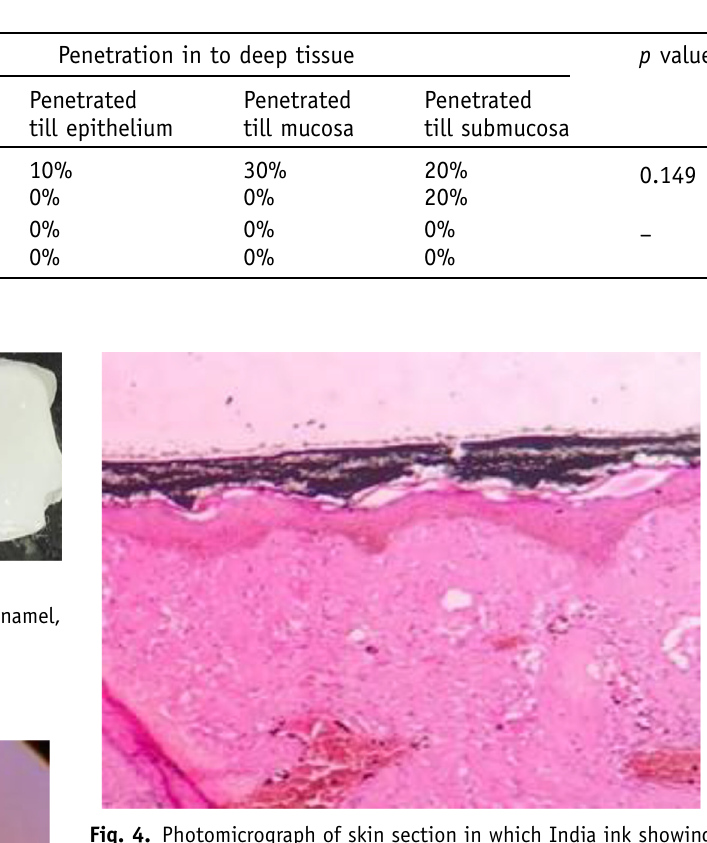
Fig. 4. Photomicrograph of skin section in which India ink showing band